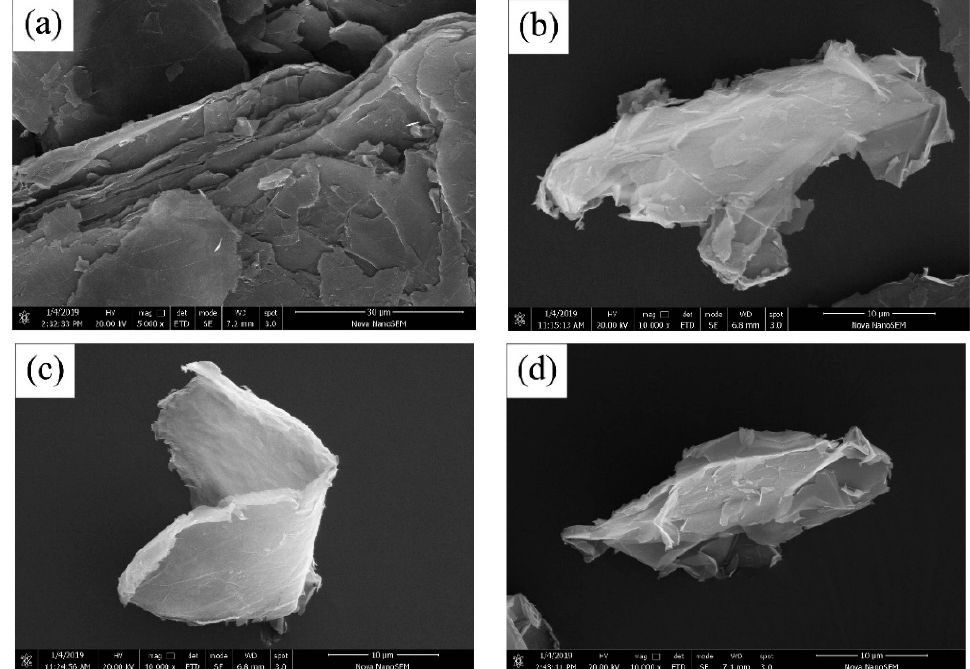
Figure 7. Scanning electron microscopy images showing the morphology of ( a ) as received GNPs; ( b ) GNPs treated with polycarboxylate superplasticizer; ( c ) GNPs treated with naphthalene su- perplasticizer; ( d ) GNPs treated with melamine superplasticizer. Reproduced from Wang et al. [105] with permission from